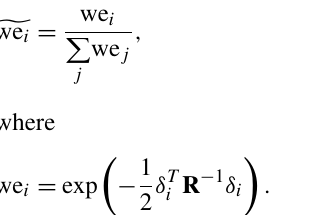
Figure A1. Weight distribution of the first 20 weights of a sorted distribution for an ensemble of 50 particles: distribution before the adjustment (blue dotted points), showing a degeneracy problem, and distribution after the adjustment procedure (red dotted points), in which weight distribution is flattened and significant weights are distributed around N keep particles (10 particles for this